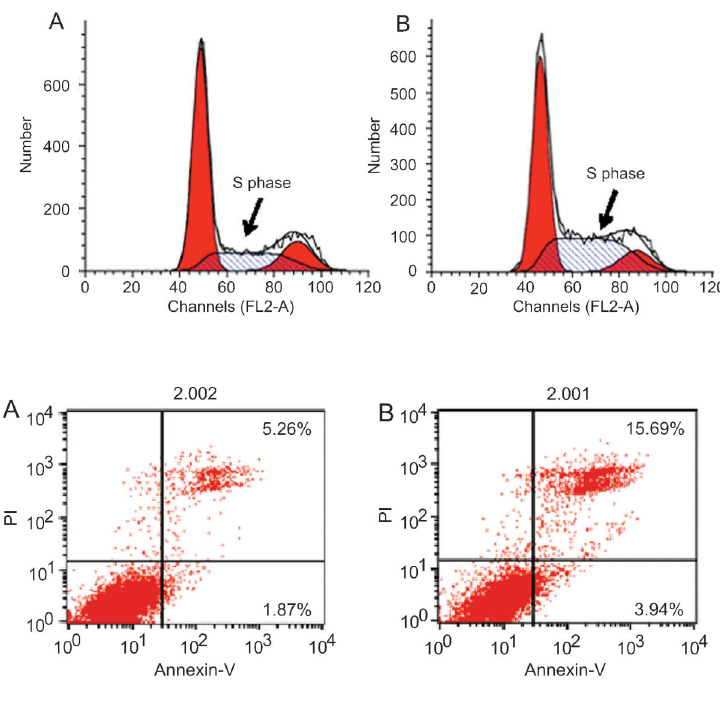
Figure 2. A , Cell cycle of normal HUVECs. B , HUVECs incubated with Ox-LDL (100 m g/mL) for